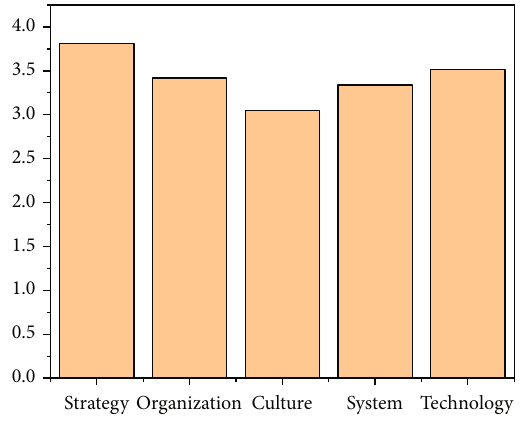
Figure 7: Average score of each